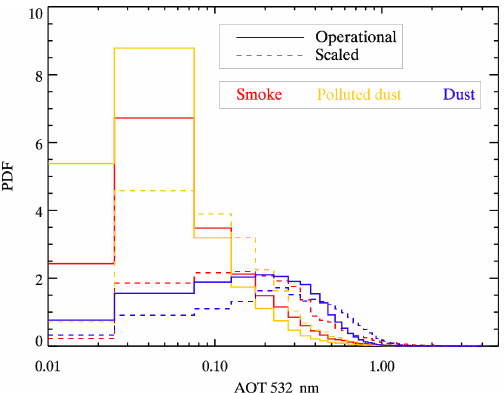
Figure 15. Comparison of the probability density function of above- cloud smoke AOT between the operational CALIOP retrieval (solid) and scaled result based on Eq. (11) (dashed). The comparison is based on 1 year (2008) of CALIOP